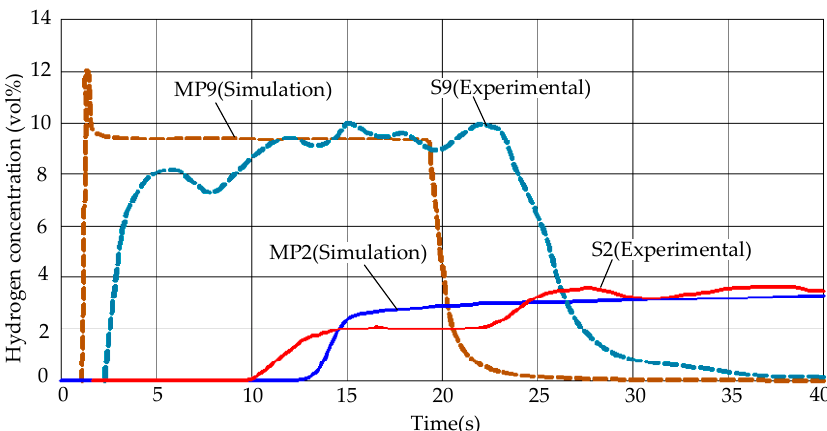
Figure 6. Comparison of the simulation results and the experimental